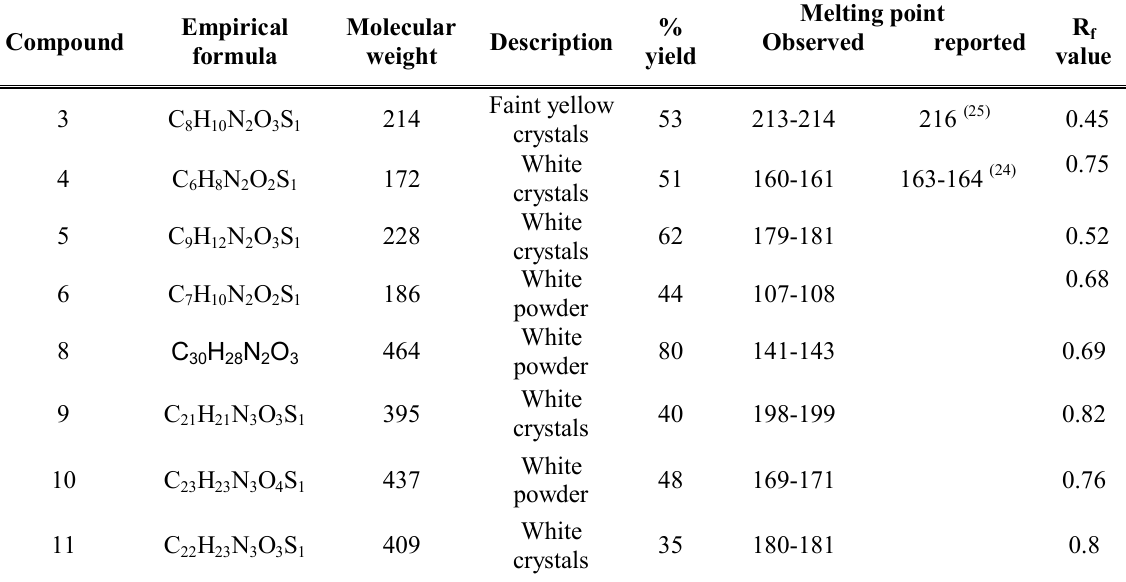
Table (1): The characterization and physical data of the compounds (3-6 and